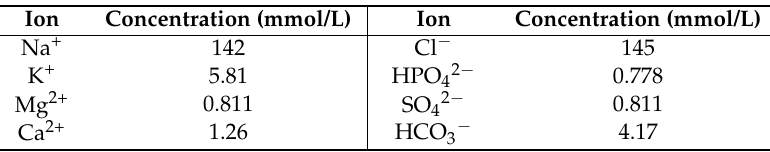
Table 1. Concentrations of electrolytes in HBSS.